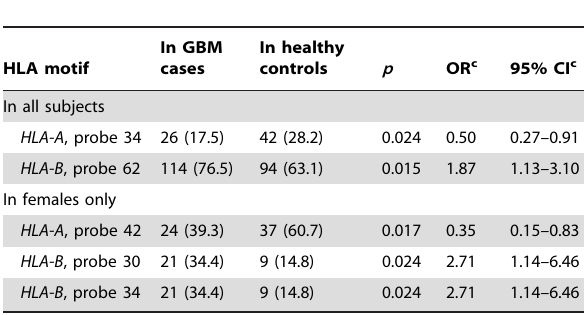
Table 4. Individual HLA class I sequence motifs associated with the occurrence of glioblasotma multiforme (GBM) in the Upper Midwest Health Study population ( N =298 subjects) or in the female subset (61 GBM patients and 61 healthy